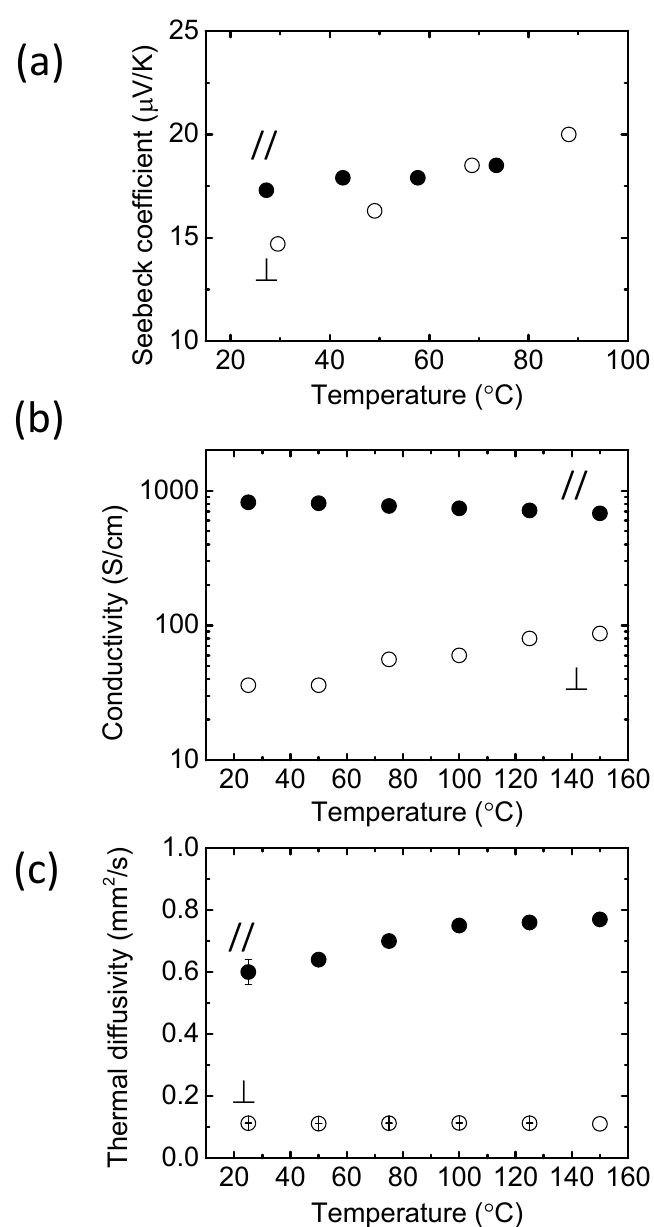
Figure 8. ( a ) Seebeck coefficient, ( b ) electrical conductivity, and ( c ) thermal diffusivity of the PEDOT/PSS films in the in-plane (closed circles) and through-plane (open circles) directions, plotted as a function of temperature. Reproduced with permission from